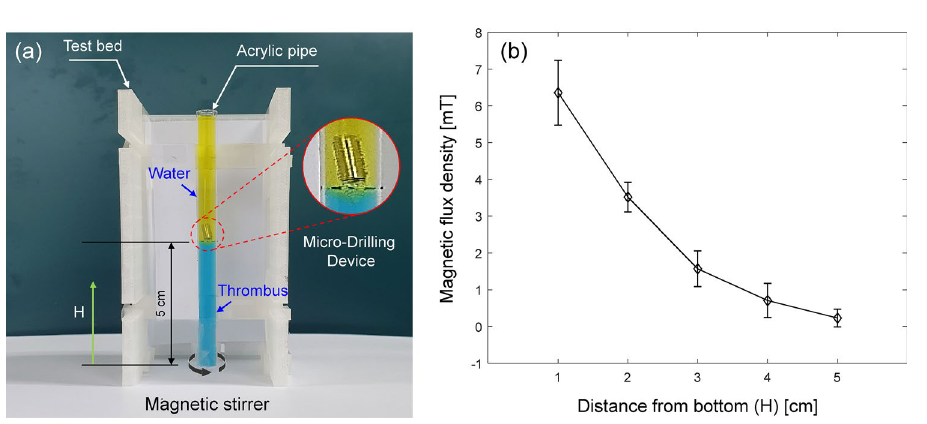
Figure 7. ( a ) Image of the experimental setup to demonstrate the drilling performance of the fabricated MDDs. ( b ) Magnetic flux density affecting the MDD along the distance from the bottom of the magnetic stirrer. Error bar represents the standard deviation (n =